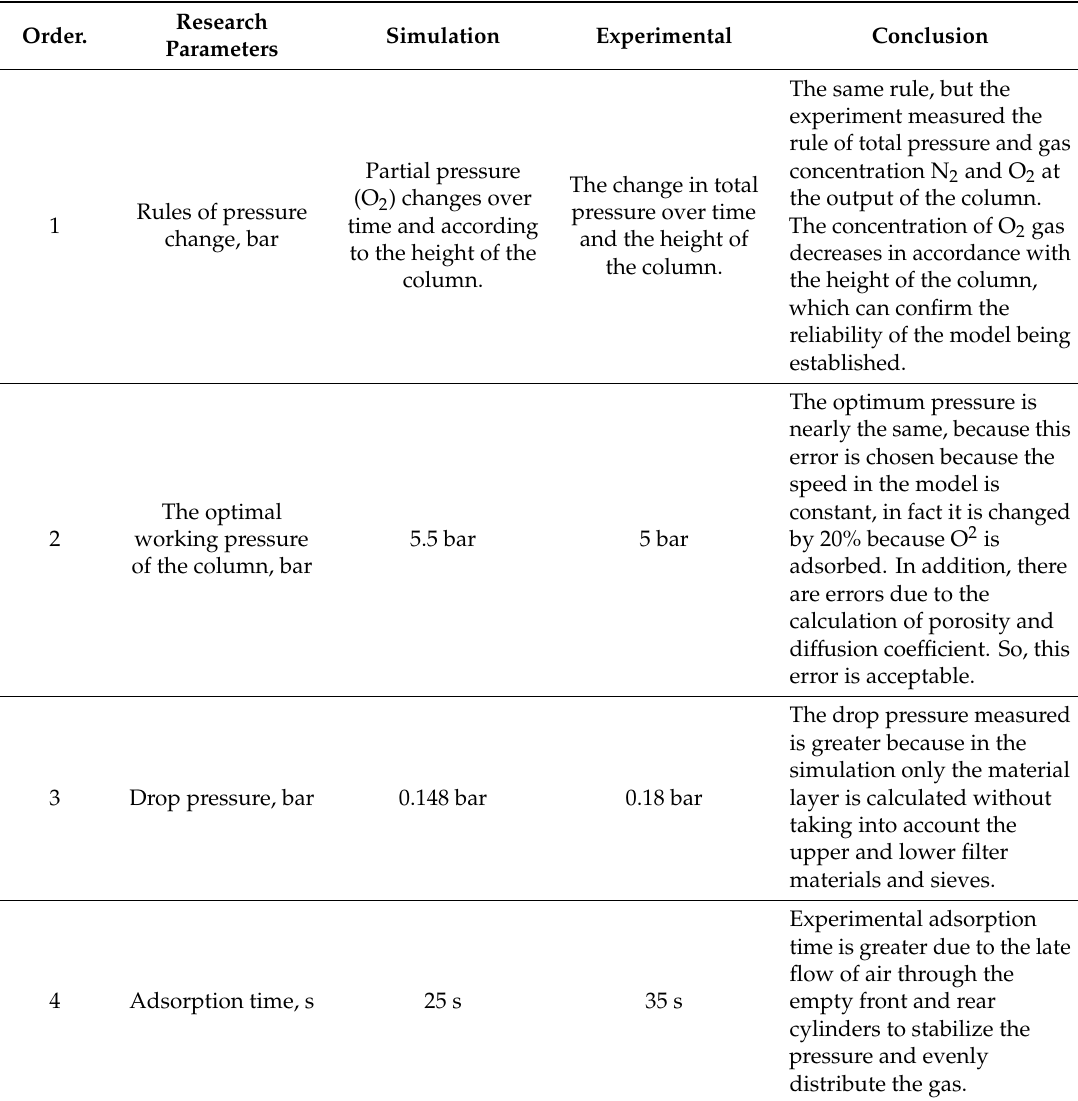
Table 5. Compare simulation and experimental